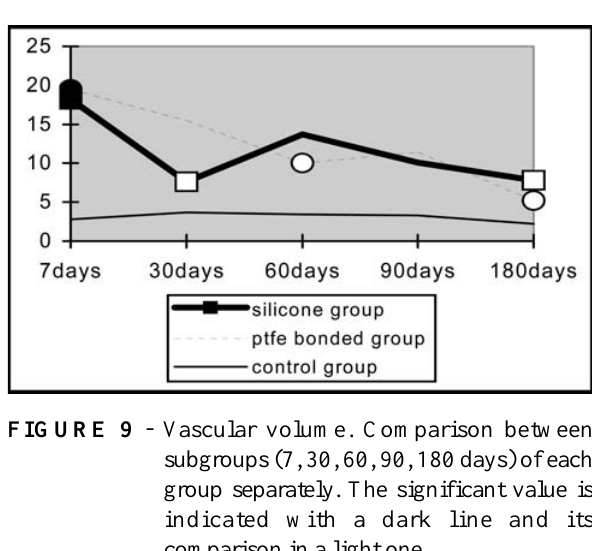
FIGURE 11 - Vascular volume. Comparison among the silicone, bonded e-ptfe and control groups in each subgroup (7, 30, 60, 90, 180 days), separately. The significant value is indicated with a dark color and its comparison in a light